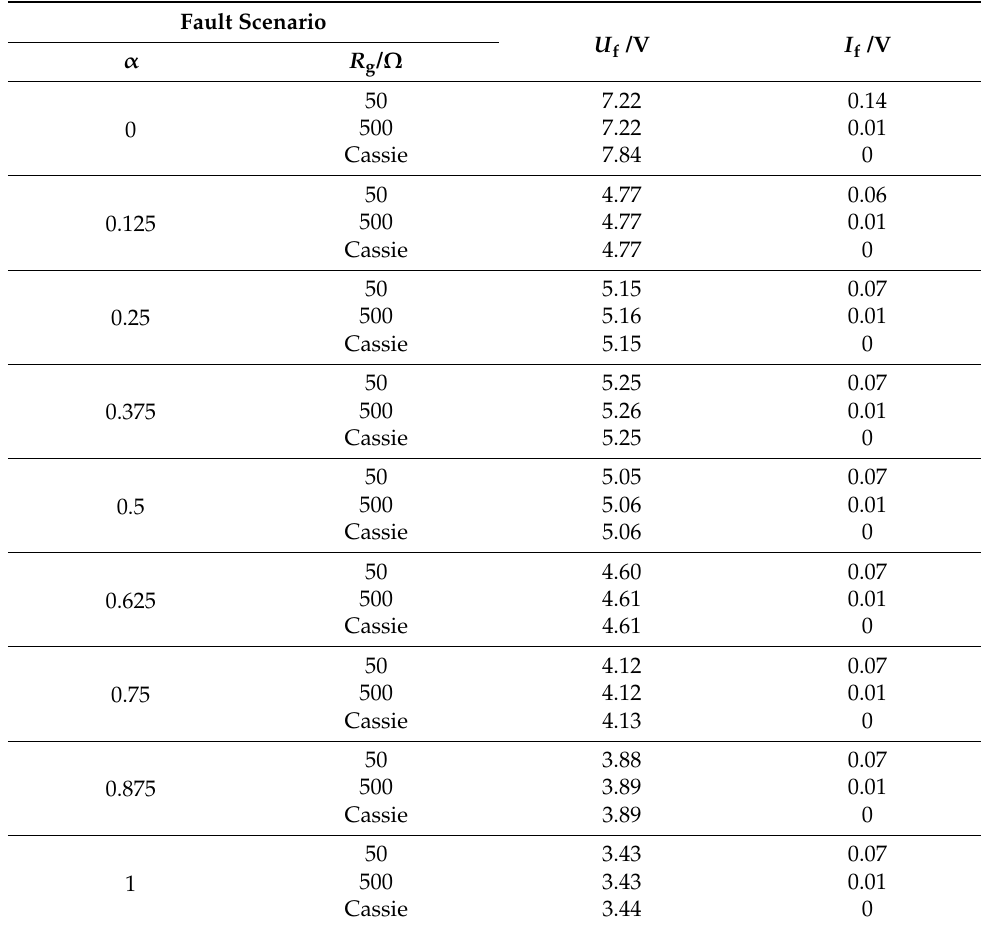
Table 3. Arc-suppression effect under different fault